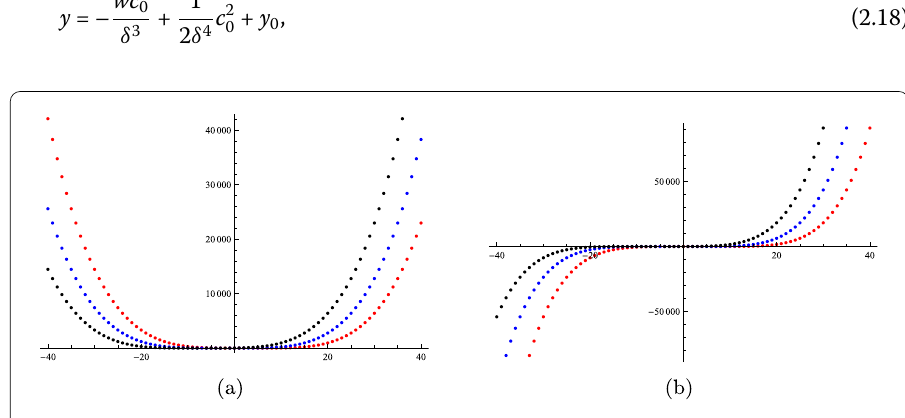
Figure 2 Background solutions of rational type. ( a ) Solution (2.12), ( b ) solution (2.15); where a = 0.5, b = 0.5, c 0 = 2, ζ 1 = ζ 3 = ζ 5 = 1, δ = 1, m ∈ [–40,40], waves in red, blue and black stand for n = –5,0,5,